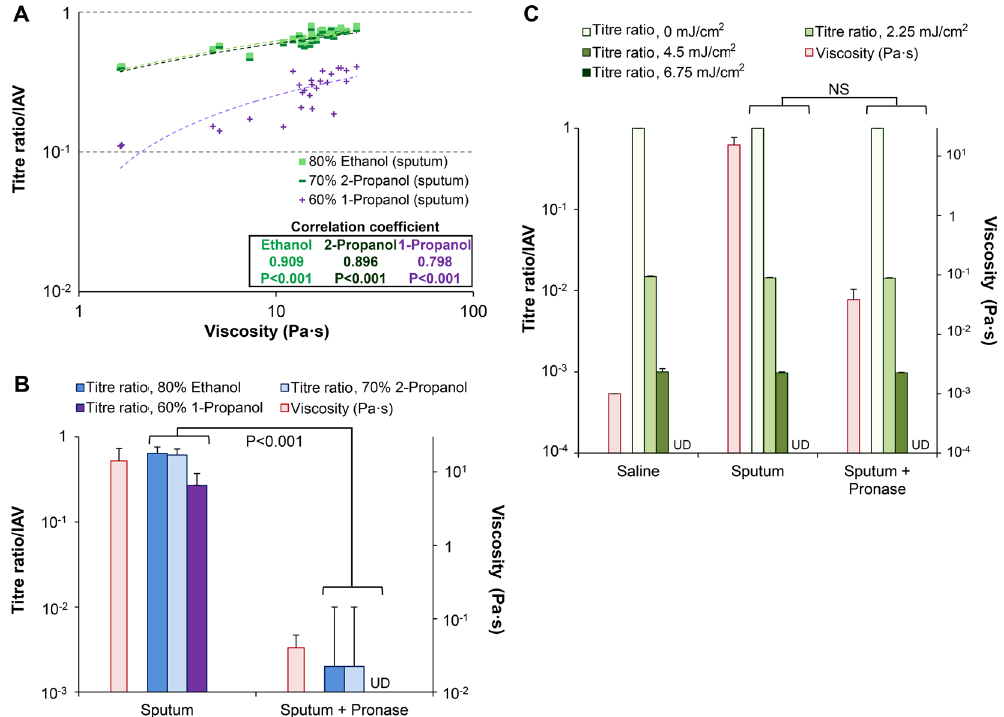
Figure 5. Correlation analysis and comparison with pronase-treated and untreated sputum samples. ( A ) Scatter plot of viscosity vs. titre ratio of 27 sputum samples. Pearson’s correlation coefficient was determined to assess the correlation between the two variables. ( B ) Titre ratios were compared between pronase-treated and untreated groups based on inactivation test results. ( C ) Resistance to UV radiation (0, 2.25, 4.5, or 6.75 mJ/cm 2 ) of IAV in sputum samples with or without pronase treatment. UD, undetectable; NS, not significant. Data are expressed as the mean ± SD based on at least three independent experiments.